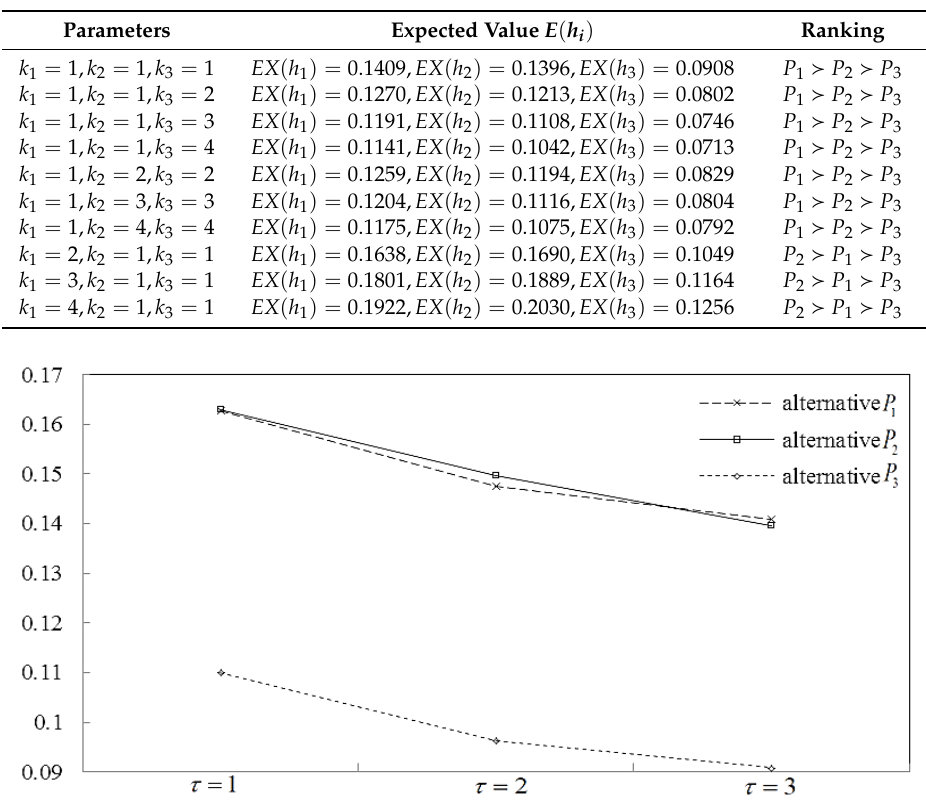
Table 6. Ranking results with di ff erent parameters k 1 , k 2 , k 3 .